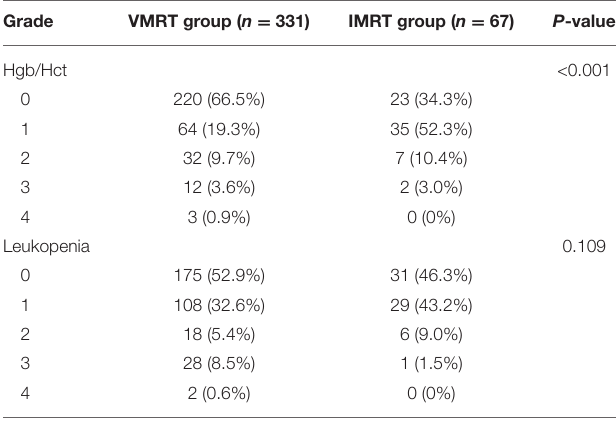
TABLE 4 | Crude incidence of acute hematotoxicity in patients with cervical cancer. Grade